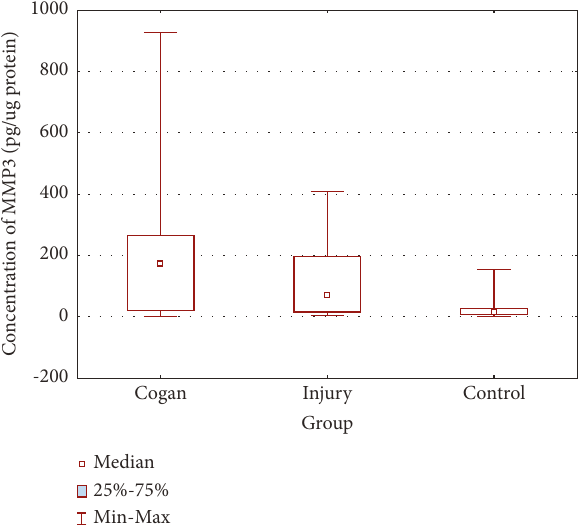
Figure 3: MMP-3 concentration values in the studied groups. Table 3: Values of MMP-2 and MMP-3 concentrations in groups 1 and 2 with and without outliers.